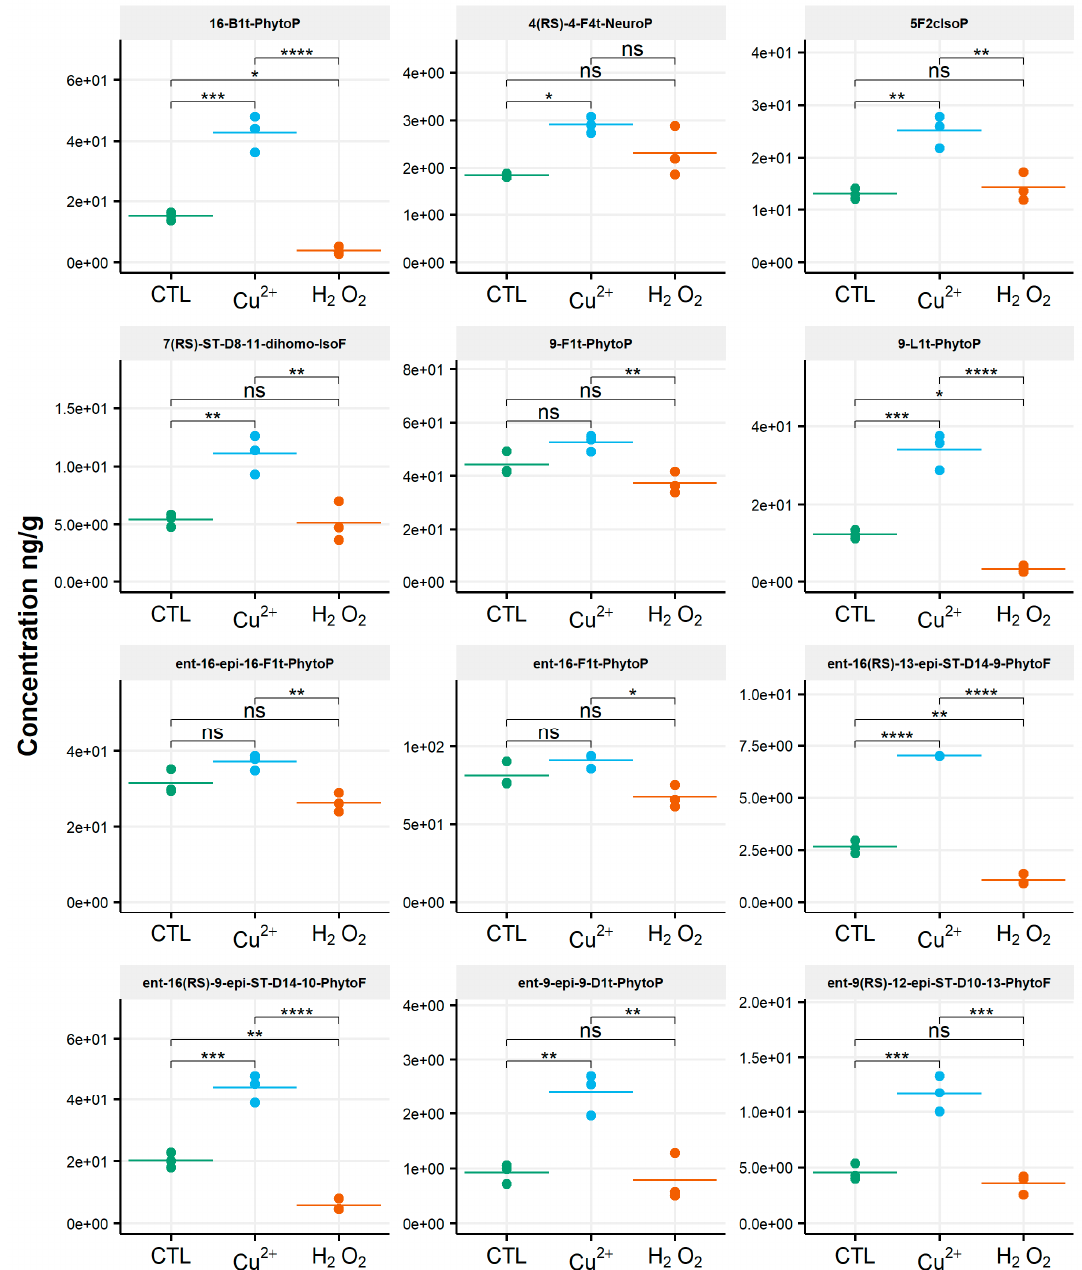
Figure 6. Changes in contents of selected isoprostanoids for the diatom Phaeodactylum tricornutum between the control condition (CTL) and oxidative stress (Cu 2+ and H 2 O 2 ) conditions. Statistically relevant responses between the control and stress conditions (one-way ANOVA) are indicated by asterisks: * p < 5 × 10 − 2 , ** p < 5 × 10 − 3 , *** p < 5 × 10 − 4 and **** p < 1 × 10 − 4 ; ns, not significant.